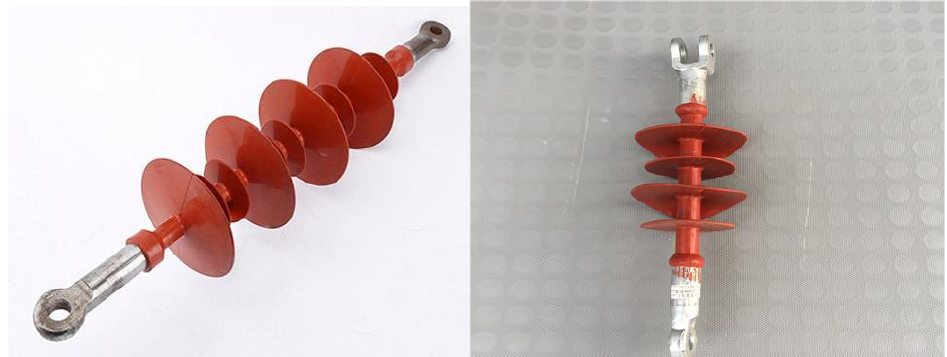
Figure 1. High-temperature vulcanized silicone rubber composite insulator.